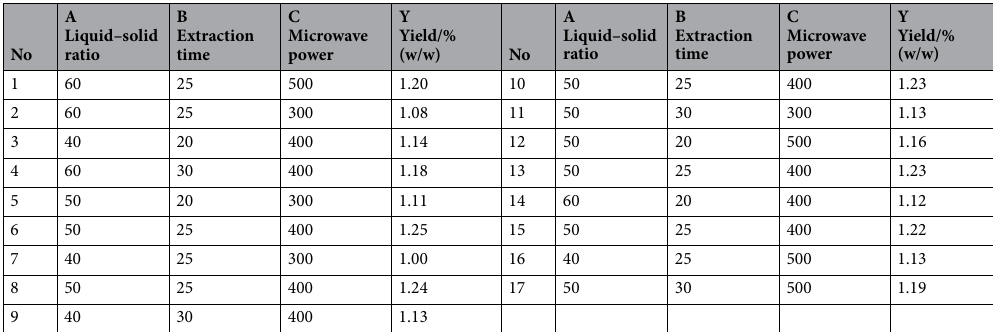
Table 4. Box–Behnken experimental design and results.